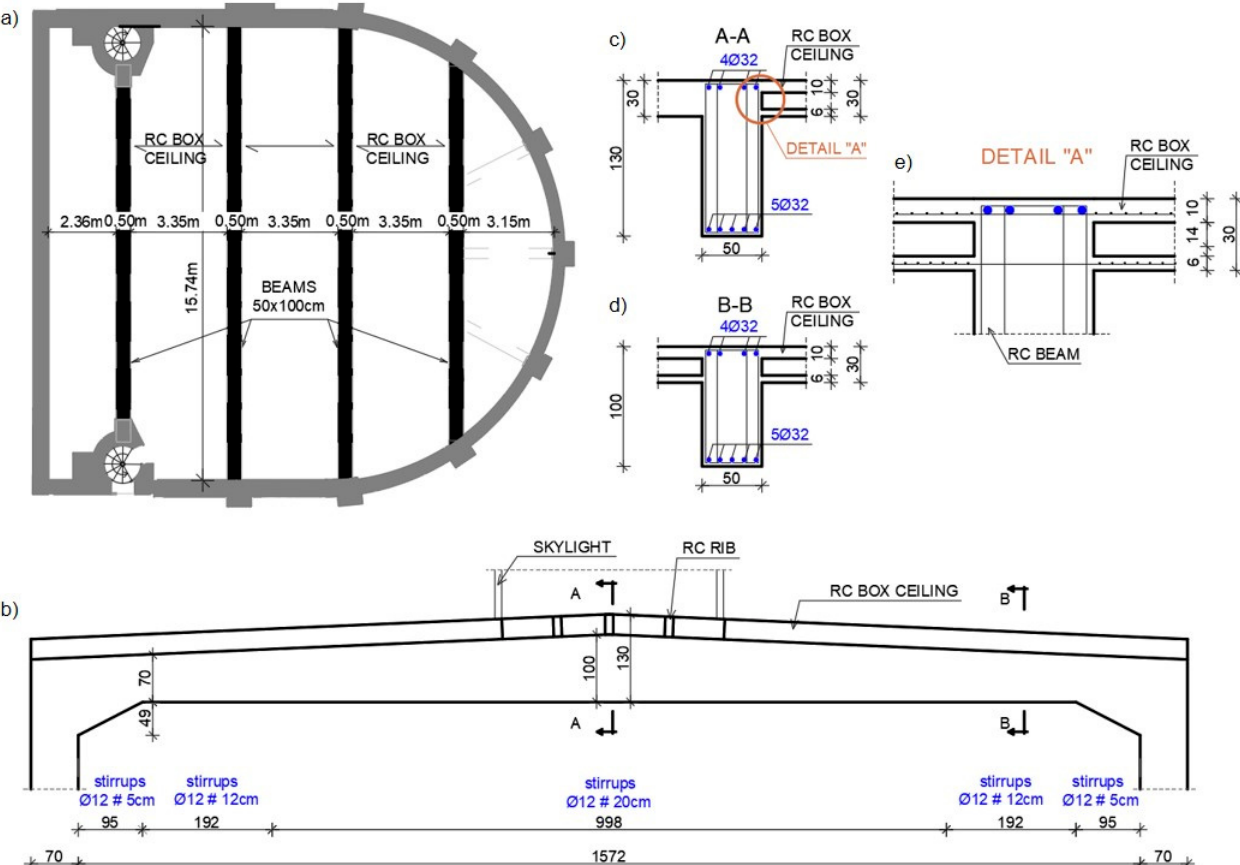
Figure 1. The layout of the roof ceiling: ( a ) plan of the beams; ( b ) view of the beam; ( c , d ) structural cross-sections of the beam; ( e ) layout of the box ceiling.